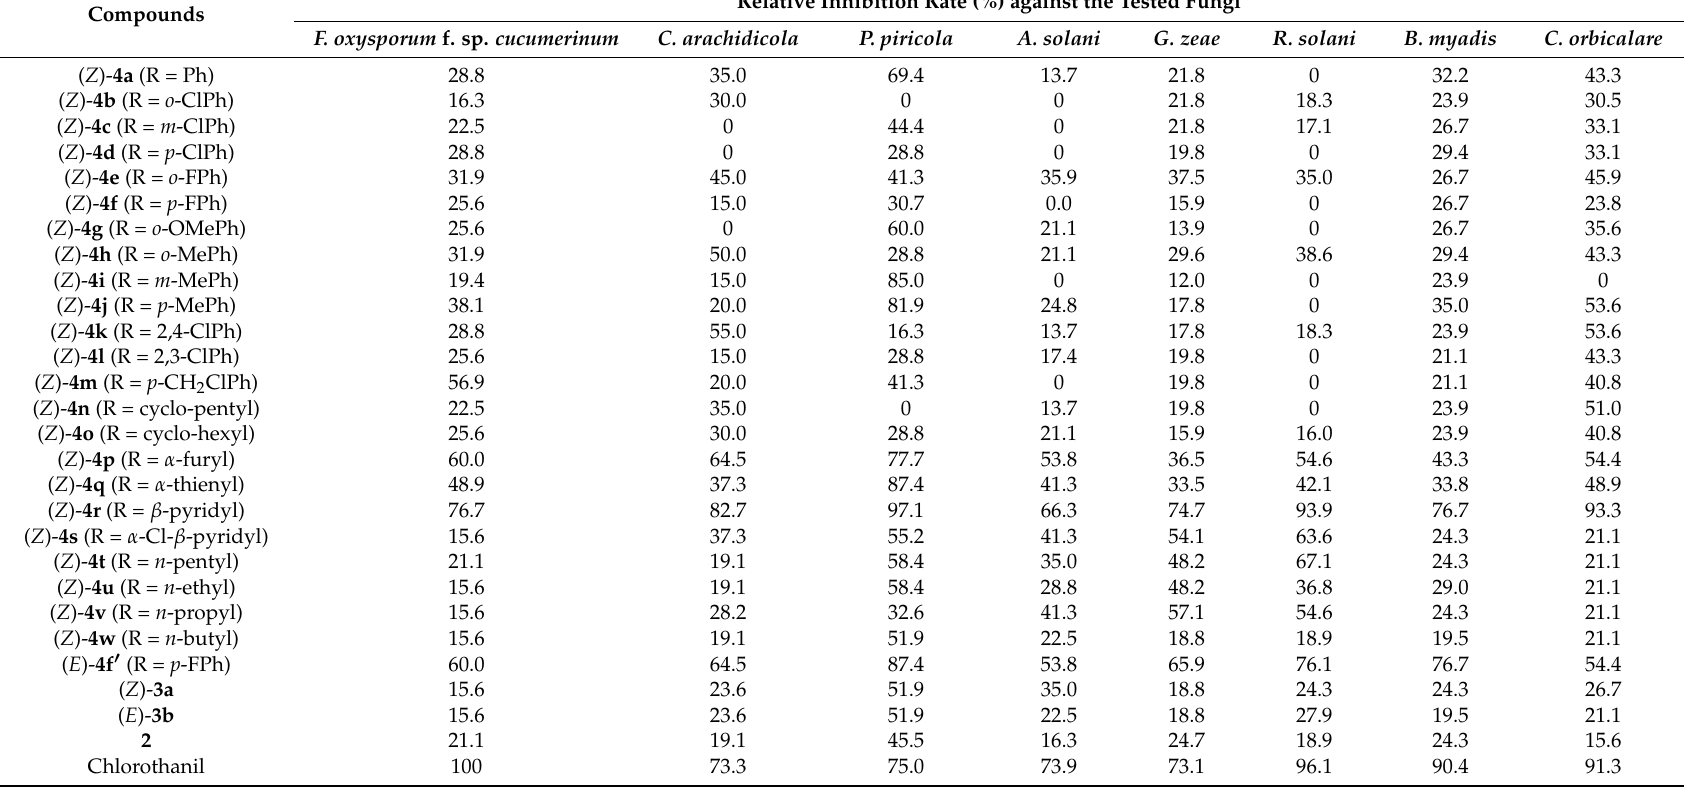
Table 1. Antifungal activity of the target compounds ( Z )- 4a – 4w and ( E )- 4f (cid:48) at 50 µ g/mL.